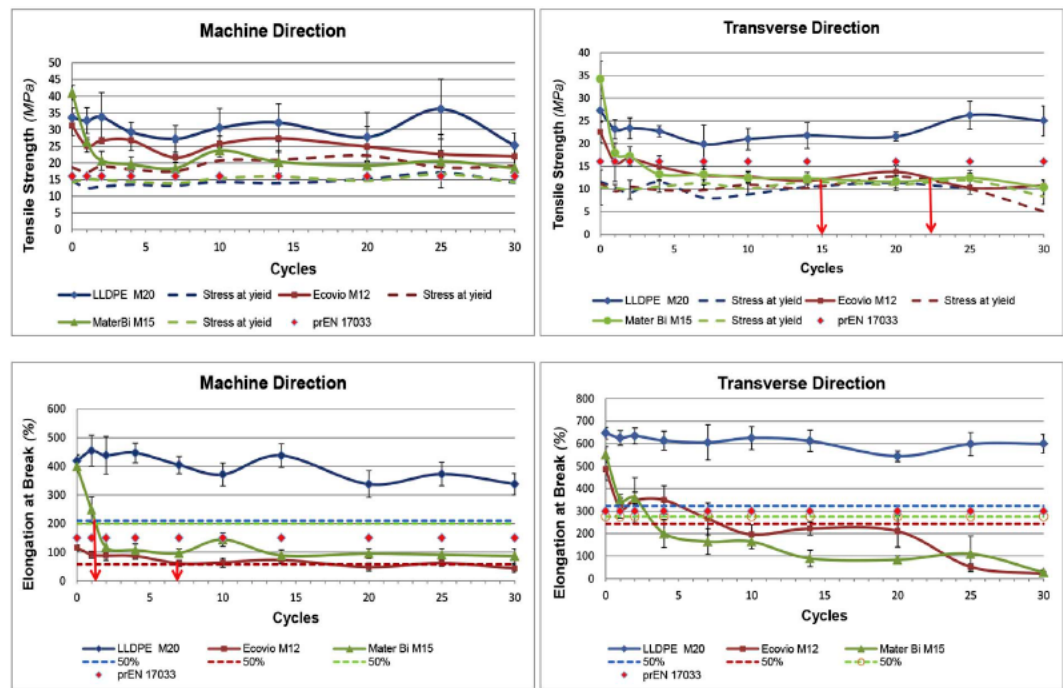
Figure 1. Tensile strength of bio-based polymers versus synthetic plastic films and cycles to failure [10].